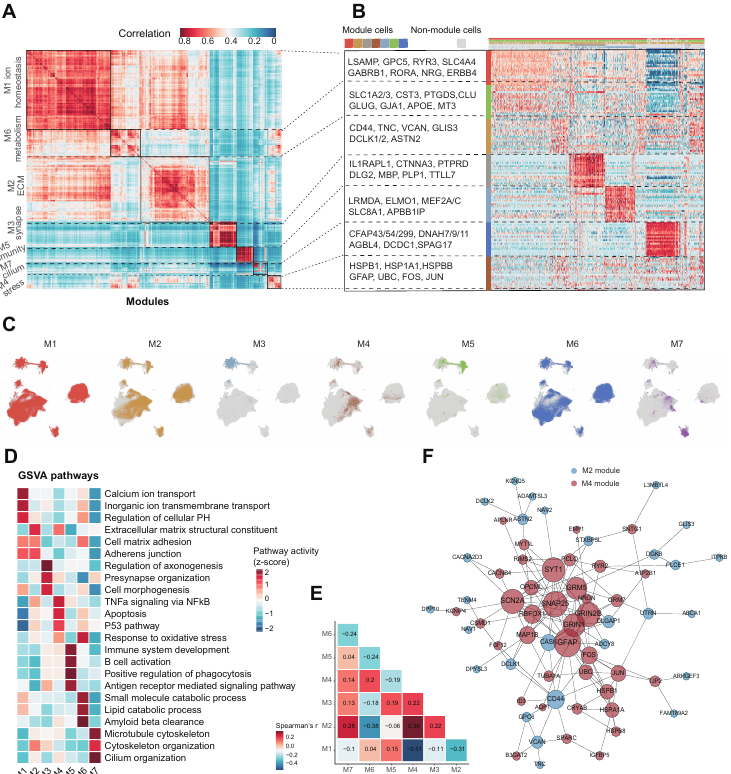
Figure 4. Identification of astrocyte transcriptomic gene modules. ( A ) Heatmap showing pairwise correlations of non-negative matrix factorization (NMF) submodules derived from 294 samples. The resembled submodules across samples are aggregated into 7 modules (M1 − M7). ( B ) Heatmap showing expression of marker genes within each module across single cells. Colors above columns correspond to cell state. ( C ) The distributions of each expression module. Cells expressing ≥ 70% of genes in each module are defined as module cells. ( D ) Heatmap showing pathway activity differences between module cells and non-module cells for each module scored by GSVA. Each column is normalized by z − score to indicate the relative pathway activities. ( E ) Heatmap showing Spearman correlation coefficients assessing for each pair of modules (rows, columns) if they are co-occurrent ( ≥ 0.3, red, positive correlation) or exclusive ( ≤− 0.3, blue, negative correlation). ( F ) The interaction networks for the M2 ECM and M4 stress modular genes (blue, M2 modular genes; red, M4 modular genes). Node size is the number of links; edges represent interactions between